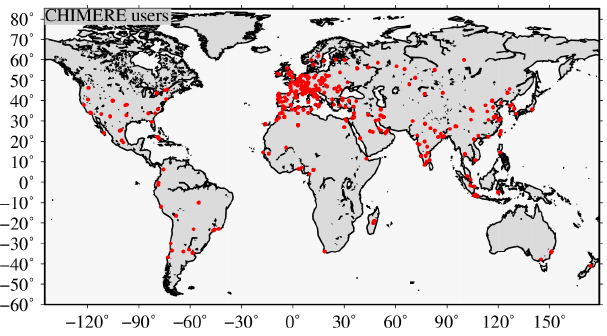
Figure 1. Map of CHIMERE users in